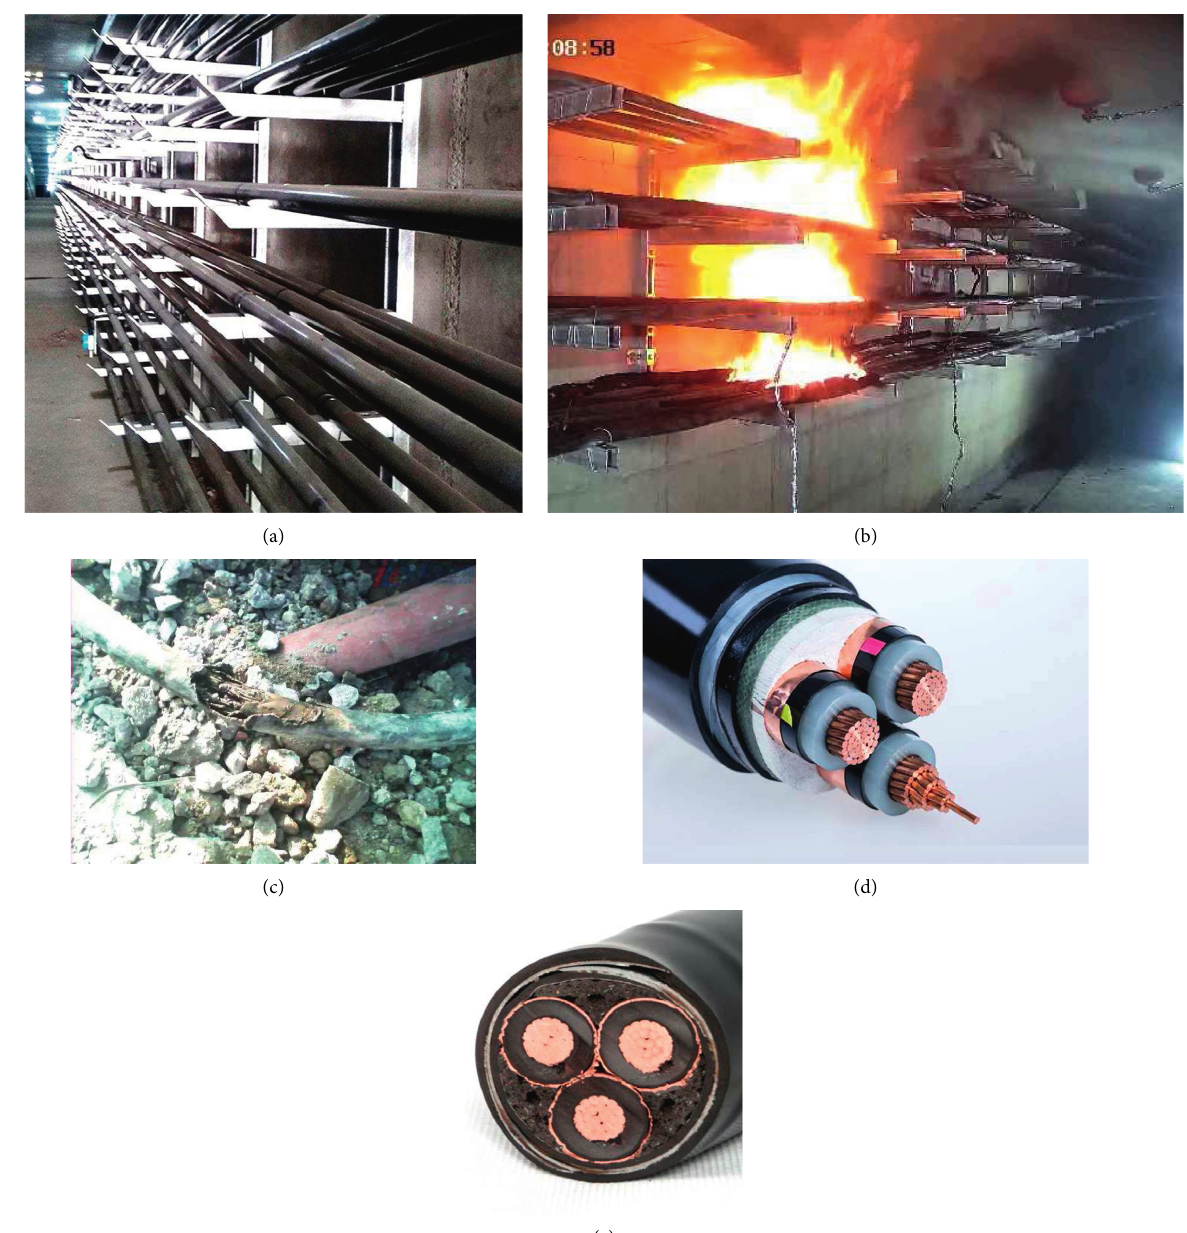
Figure 1: (a) Picture of cable laying; (b) photo of cable fire; (c) picture of cable insulation damage; (d) picture of structural analysis of three- core cable; (e) picture of cable radial